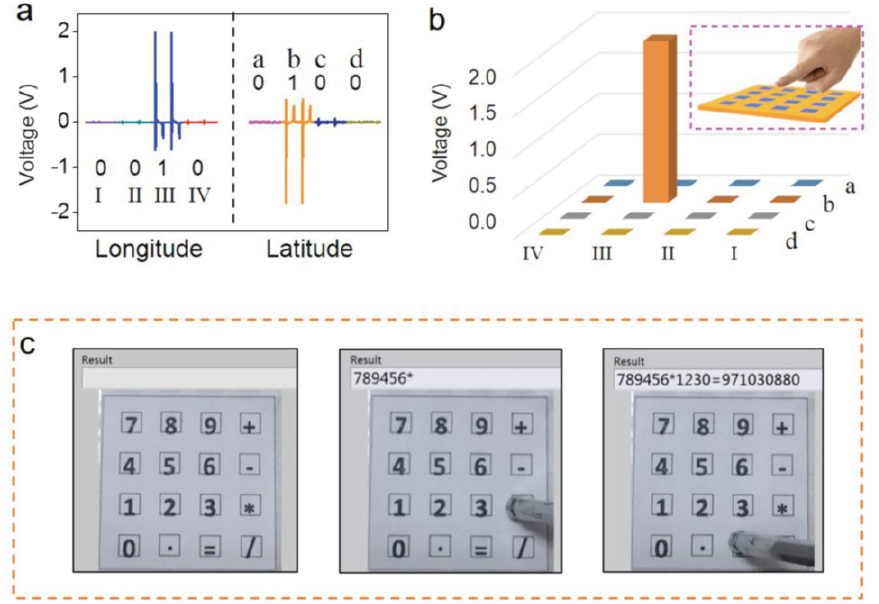
Figure 10. PATSA works as a calculator. ( a ) Longitude and latitude voltage data plots from the eight-channel electrodes of the PATSA when pixel (III-b) was subjected to a force.( b ) Derived histogram sketch for this scenario. ( c ) Assembled flexible PATSA calculator. Reprinted with permission from [90] c (cid:13) 2015 Wiley online